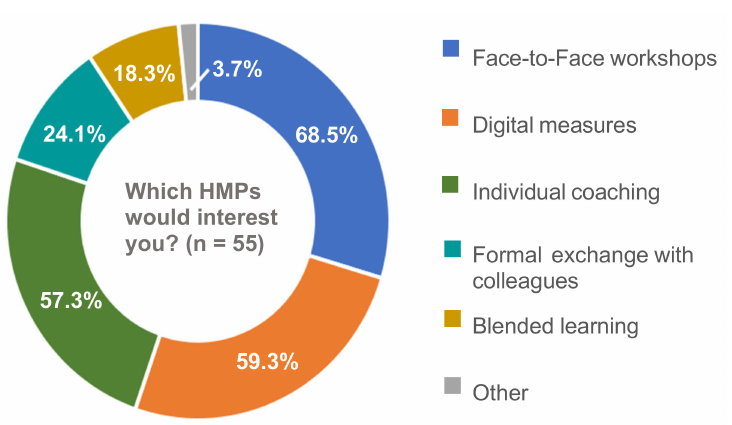
Figure 2. Frequencies of Managers’ Interest in HPM Modes (conditional question, multiple re- sponse